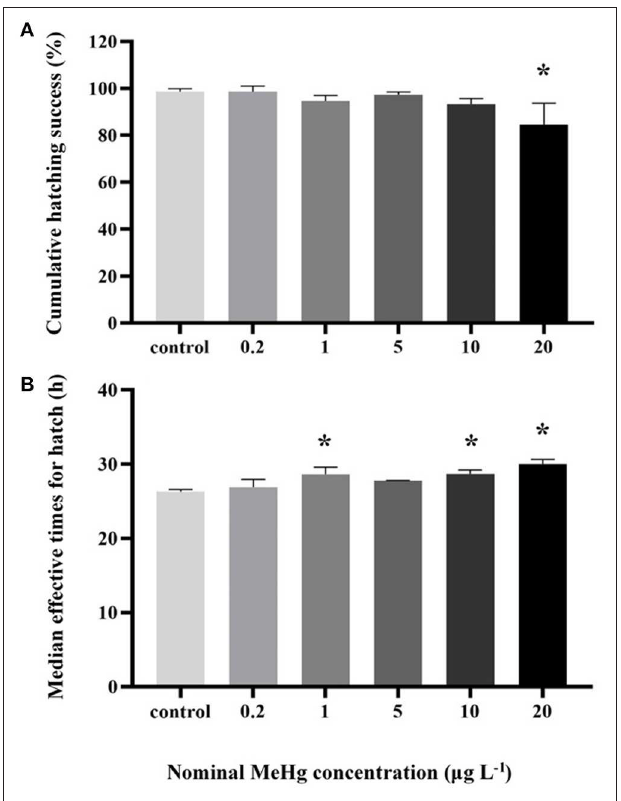
FIGURE 2 | Heart rate of the large yellow croaker (A) embryos and (B) larvae by MeHg exposure (mean ± S.D.; n = 3; *indicated significant difference compared to the control group at p <